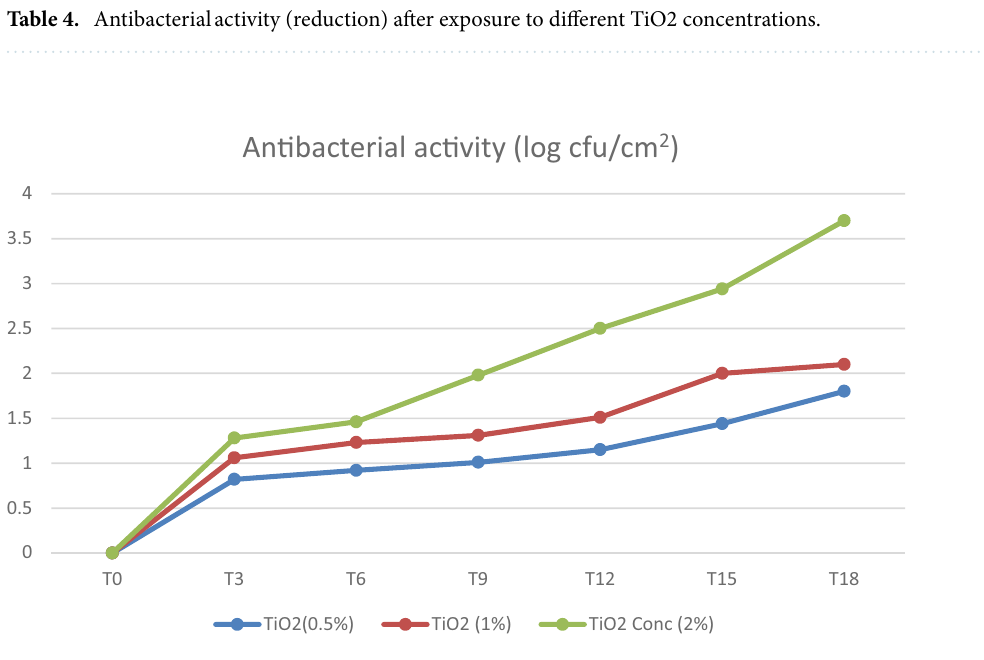
Figure 1. Antibacterial activity of TiO2 nanoparticles against E. coli.